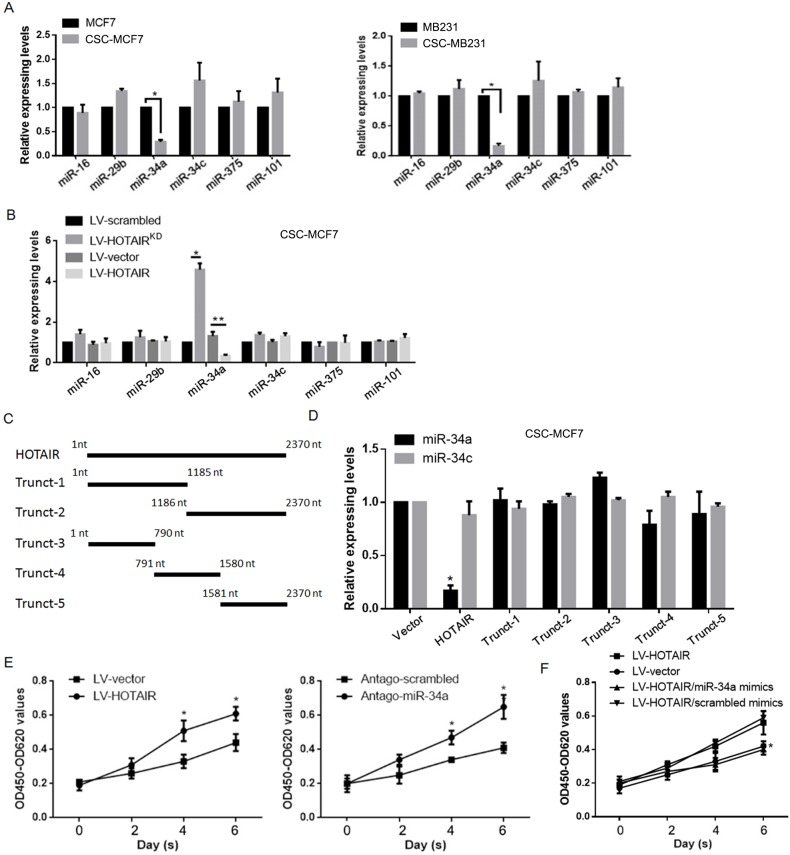
Expression of HOTAIR transcriptionally inhibits expression of miR-34a.(A) The levels of miR-16, miR-29b, miR-34a, miR-34c, miR-375 and miR-101 expression were detected in CSC-MCF7 or CSC-MB231 by RT-qPCR. (B) After transfection of LV-scrambled, LV-HOTAIRKD, or LV-HOTAIR into CSC-MCF7 cells, the miRNAs mentioned above were detected by RT-qPCR. (C) HOTAIR truncations were cloned. (D) After the transfection of the truncations, the levels of miR-34a and miR-34c in transfected CSC-MCF7 cells were detected by RT-qPCR. (E) For comparison of the effect of HOTAIR and miR-34a on proliferation, CCK-8 assays were performed in these transfected cells. (F) After co-transfection of LV-HOTAIR with miR-34a mimics or scrambled mimics, CCK-8 assays were performed. *P<0.05, **P<0.01.